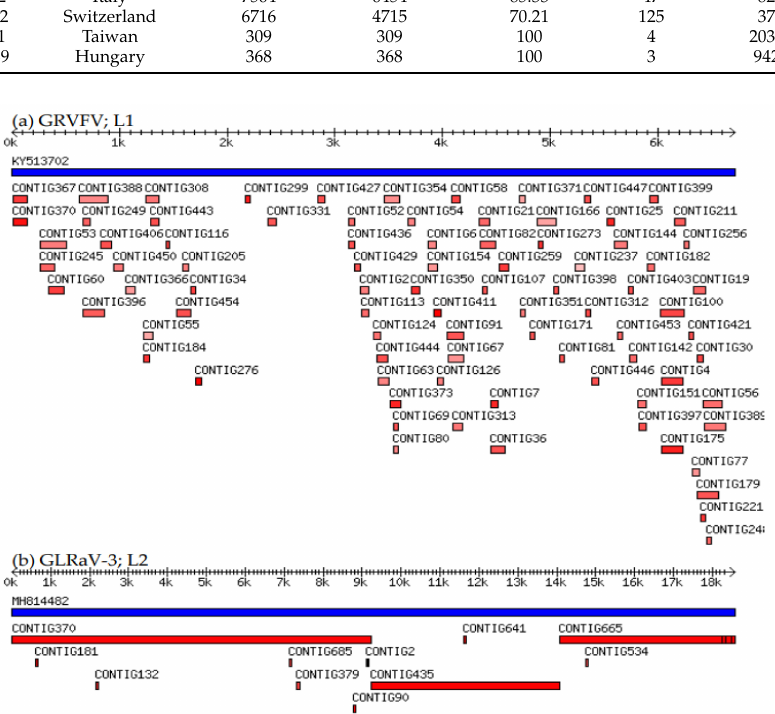
Figure 2. Virus-assembled contigs (red bars) mapped to complete reference genome sequence (blue bars): ( a ) GRVFV, virus with the lowest reference genome coverage (61.99%; L1); ( b ) GLRaV-3, virus with the highest reference genome coverage (99.96%;